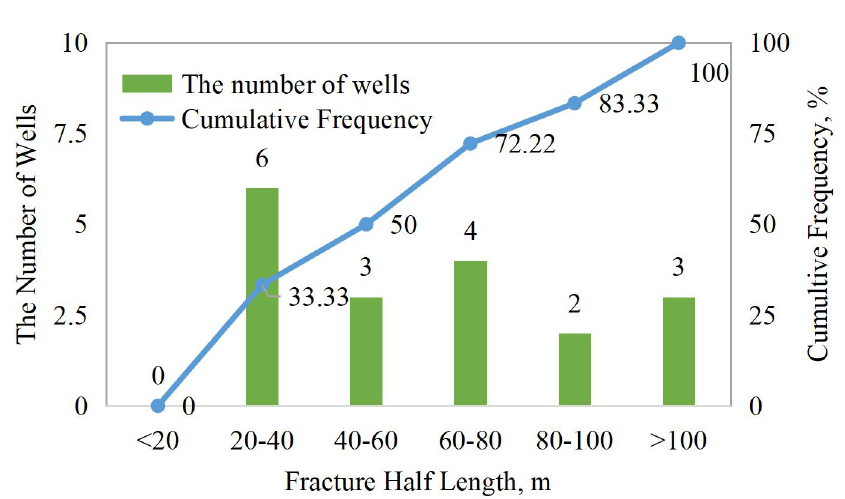
Figure 15—Cumulative frequency distribution of horizontal well fracture half length.